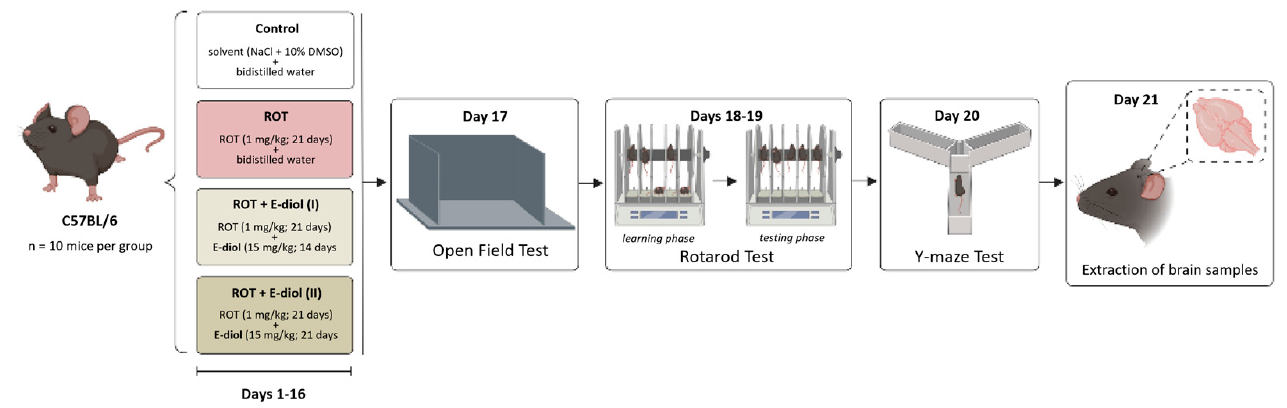
Figure 6. An in vivo scheme of the series of experiments aimed at investigating the neuroprotective potential of epoxidiol (E-diol, 15 mg/kg) with intraperitoneal administration (i. p.) under conditions of rotenone-induced model (ROT, 1 mg/kg, i. p.)